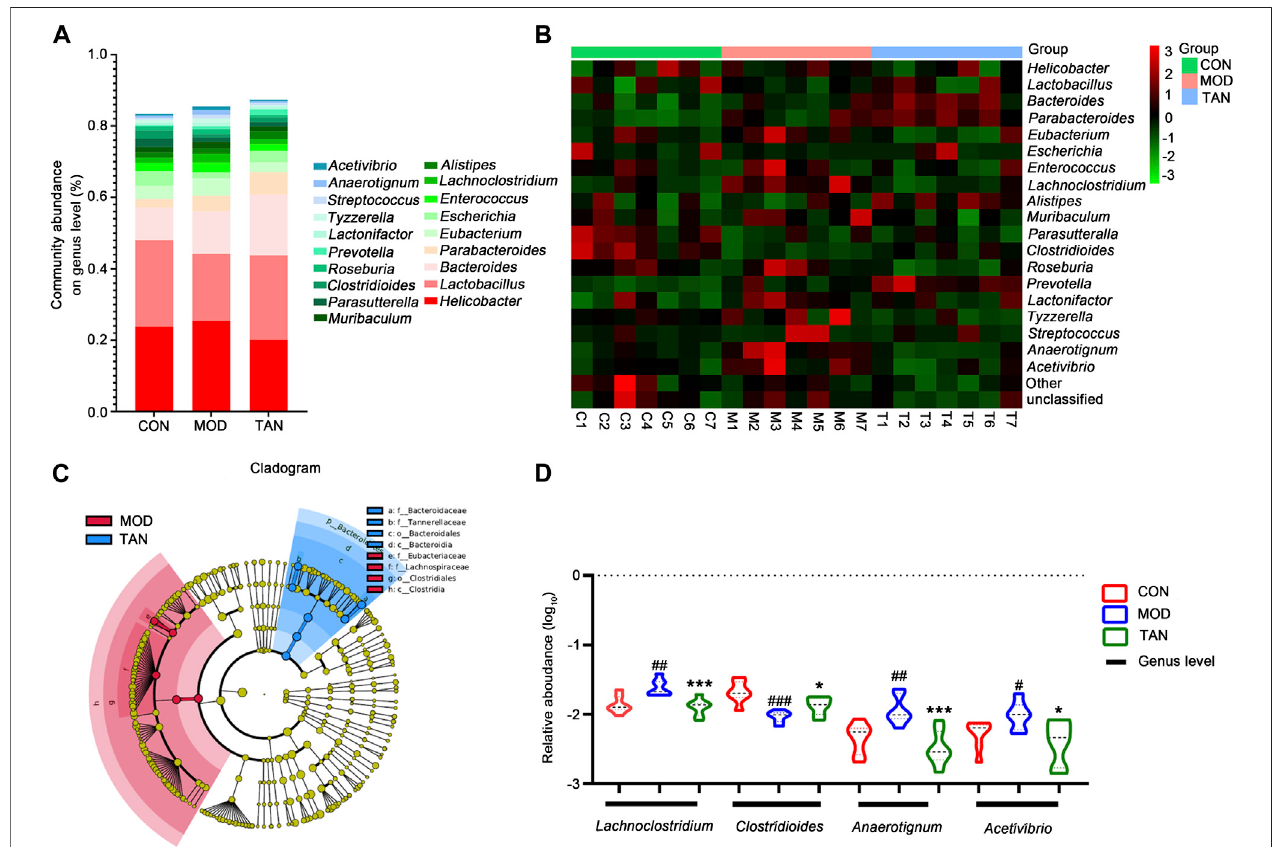
FIGURE 5 | The effect of TAN on the abundance of the gut microbiome at the genus level ( n = 7 rats in each group). (A) The relative abundance of the top-ranked genera among the three groups. (B) Hierarchical clustering heat map of the top differentiated taxa at the genus level among the three groups. (C) Feature genera in the MOD and TAN groups atthe LDA4levelasanalysedbyLDA effect size. Therewere nofeature generadetected in theCON groupat theLDA4 level. (D) The comparison of the relative abundance (log10) of Lachnoclostridium , Clostridioides , Anaerotignum , and Acetivibrio in the three groups. # p < 0.05, ## p < 0.01, ### p < 0.001 vs . CON group and * p < 0.05, *** p < 0.001 vs . MOD group. Differences were examined by unpaired t test. TAN, tanshinone IIA; CON, control; MOD, model; LDA, linear discriminant